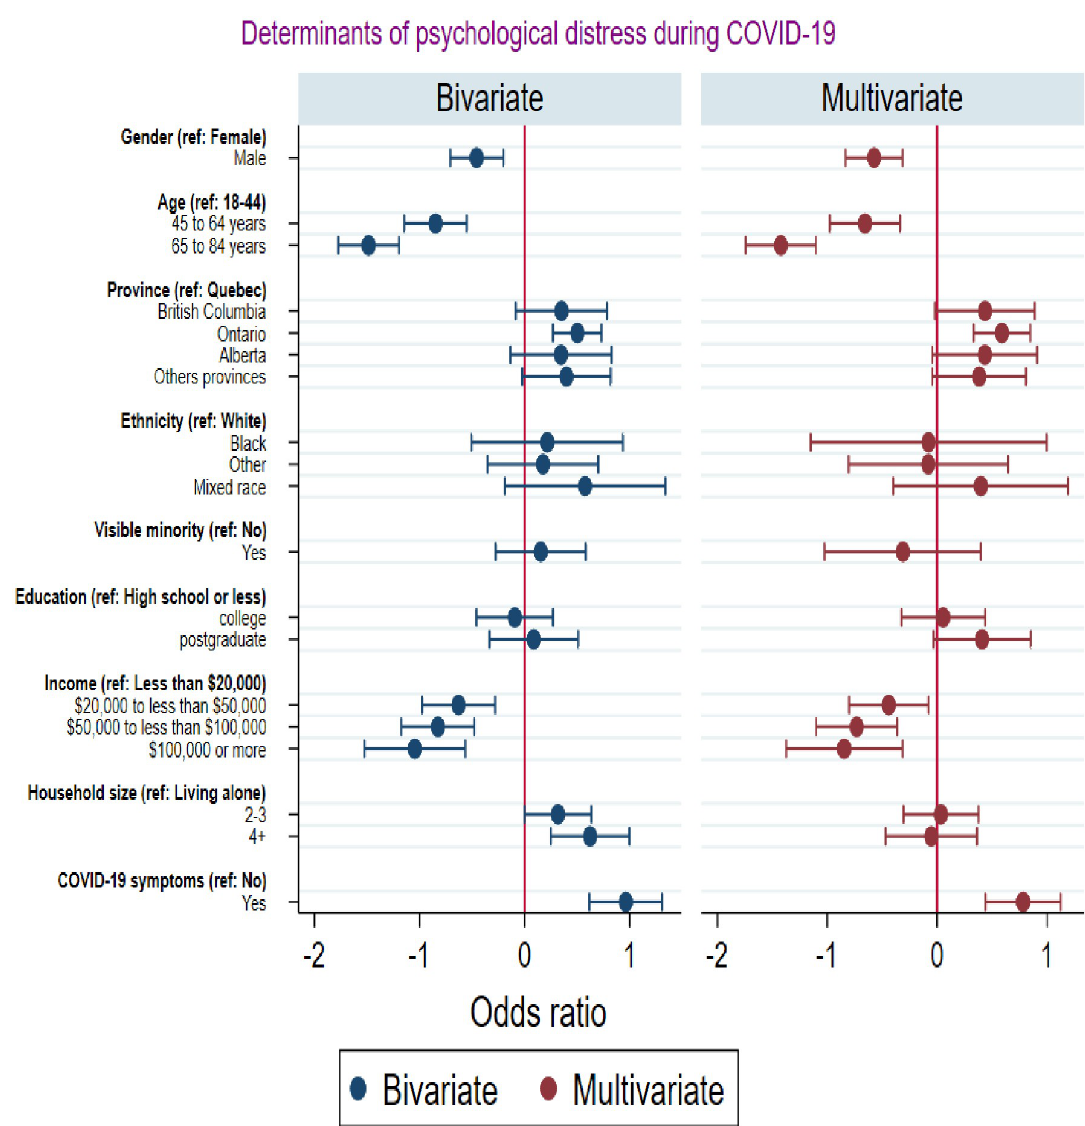
Fig 3. Multinomial logit results on the predictors of psychological